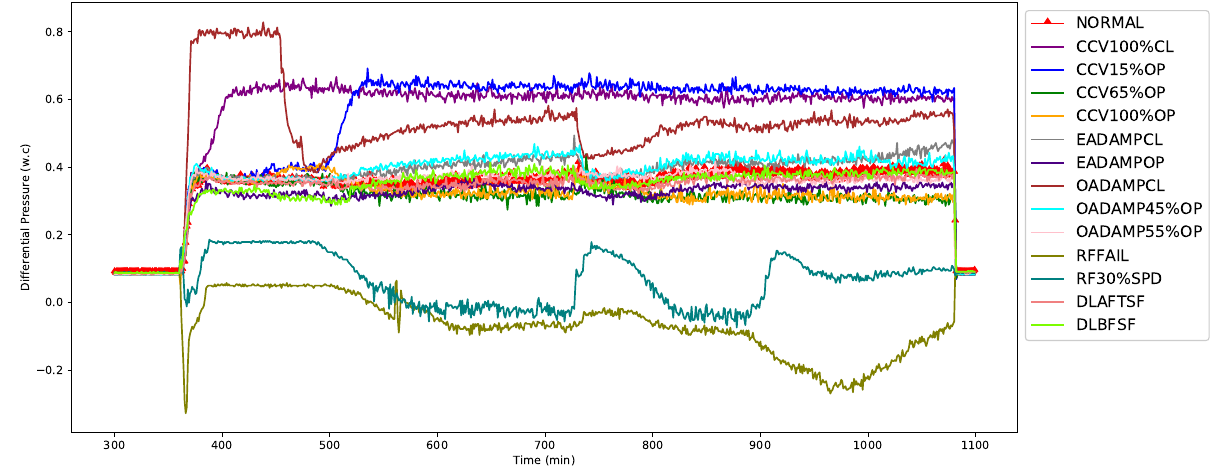
Figure 4. First-top feature: Return air fan differential pressure (RF-DP).